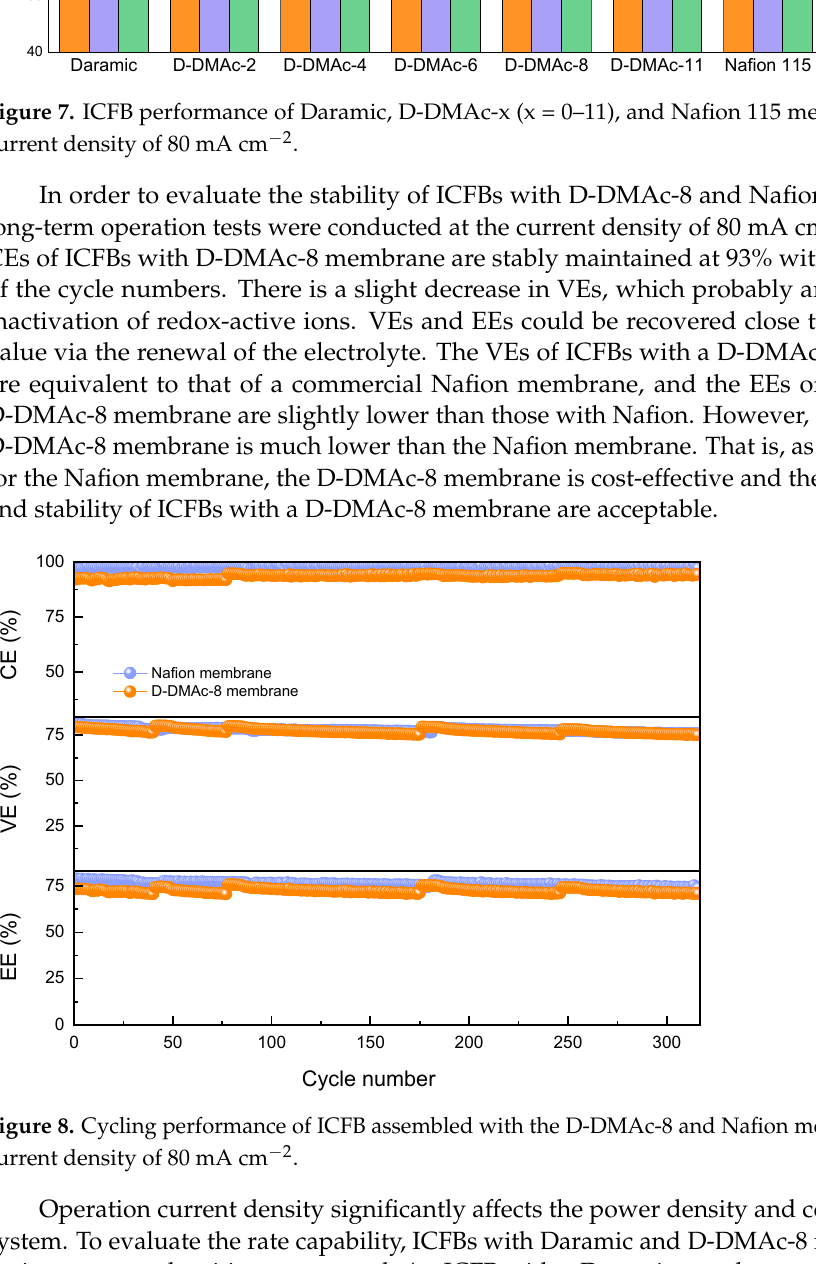
Figure 7. ICFB performance of Daramic, D-DMAc-x (x = 0–11), and Nafion 115 membranes at the current density of 80 mA cm − 2 .